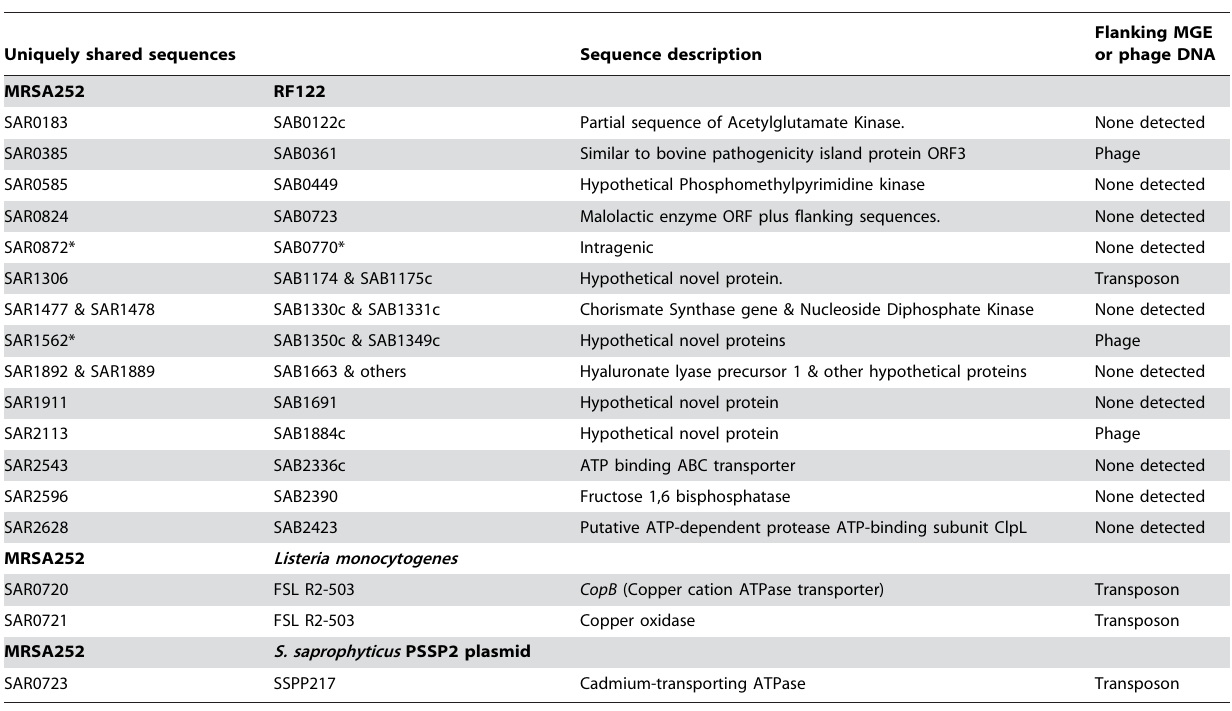
Table 1. MRSA252 uniquely shares multiple DNA sequences with other causative agents of bovine mastitis.